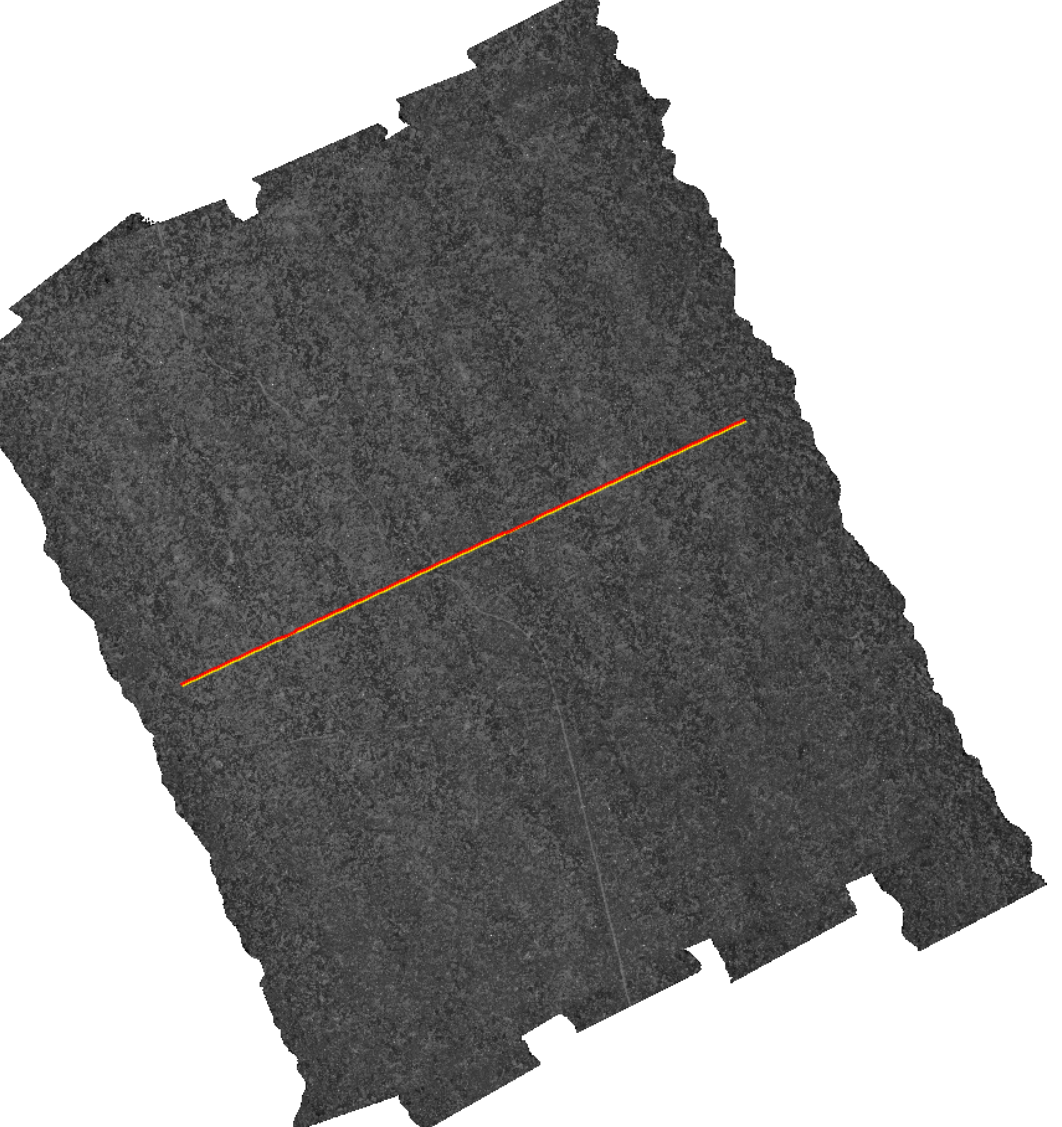
Figure 15. Trajectory in yellow on intensity, square bin, experiment. Corresponding estimated positions are drawn in